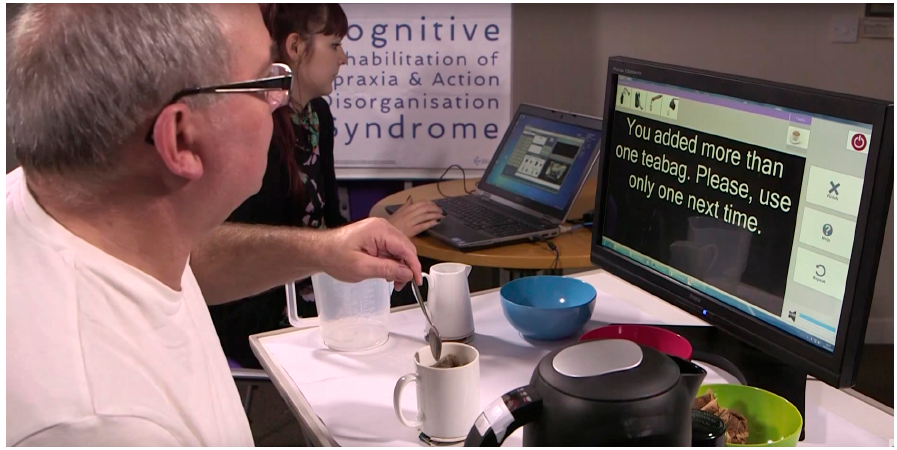
Figure 2. Interacting with the CogWatch system.